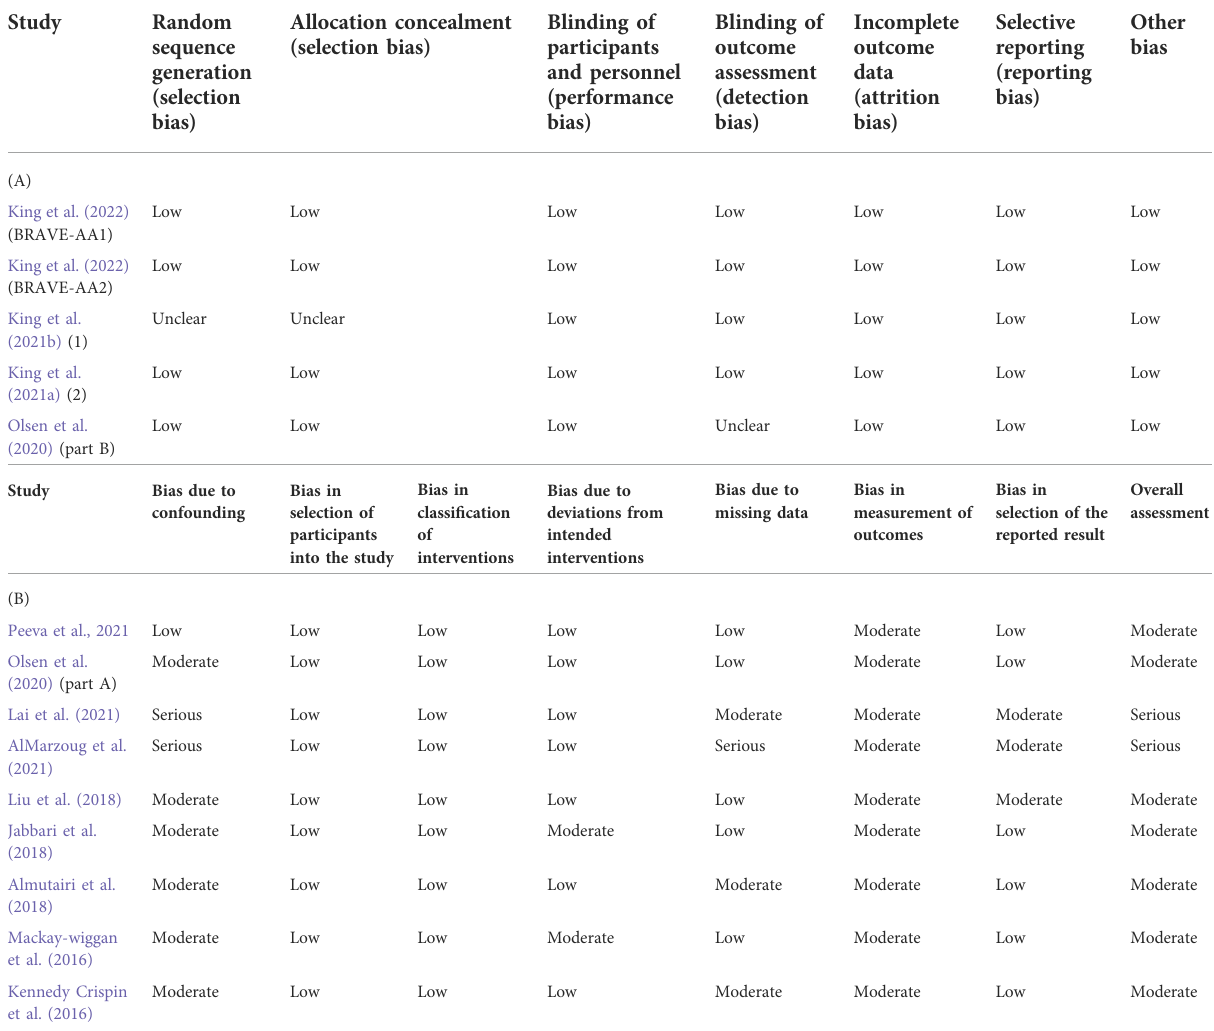
TABLE 2 Risk of bias in (A) included RCTs and (B) included